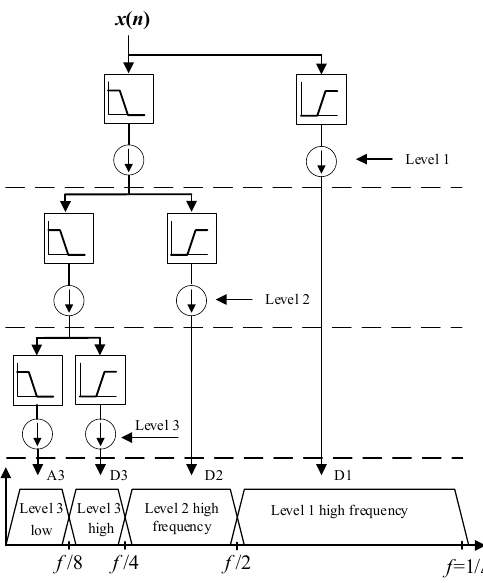
Figure 4. Discrete wavelets transform with 3 levels of high-pass and low-pass filter banks.